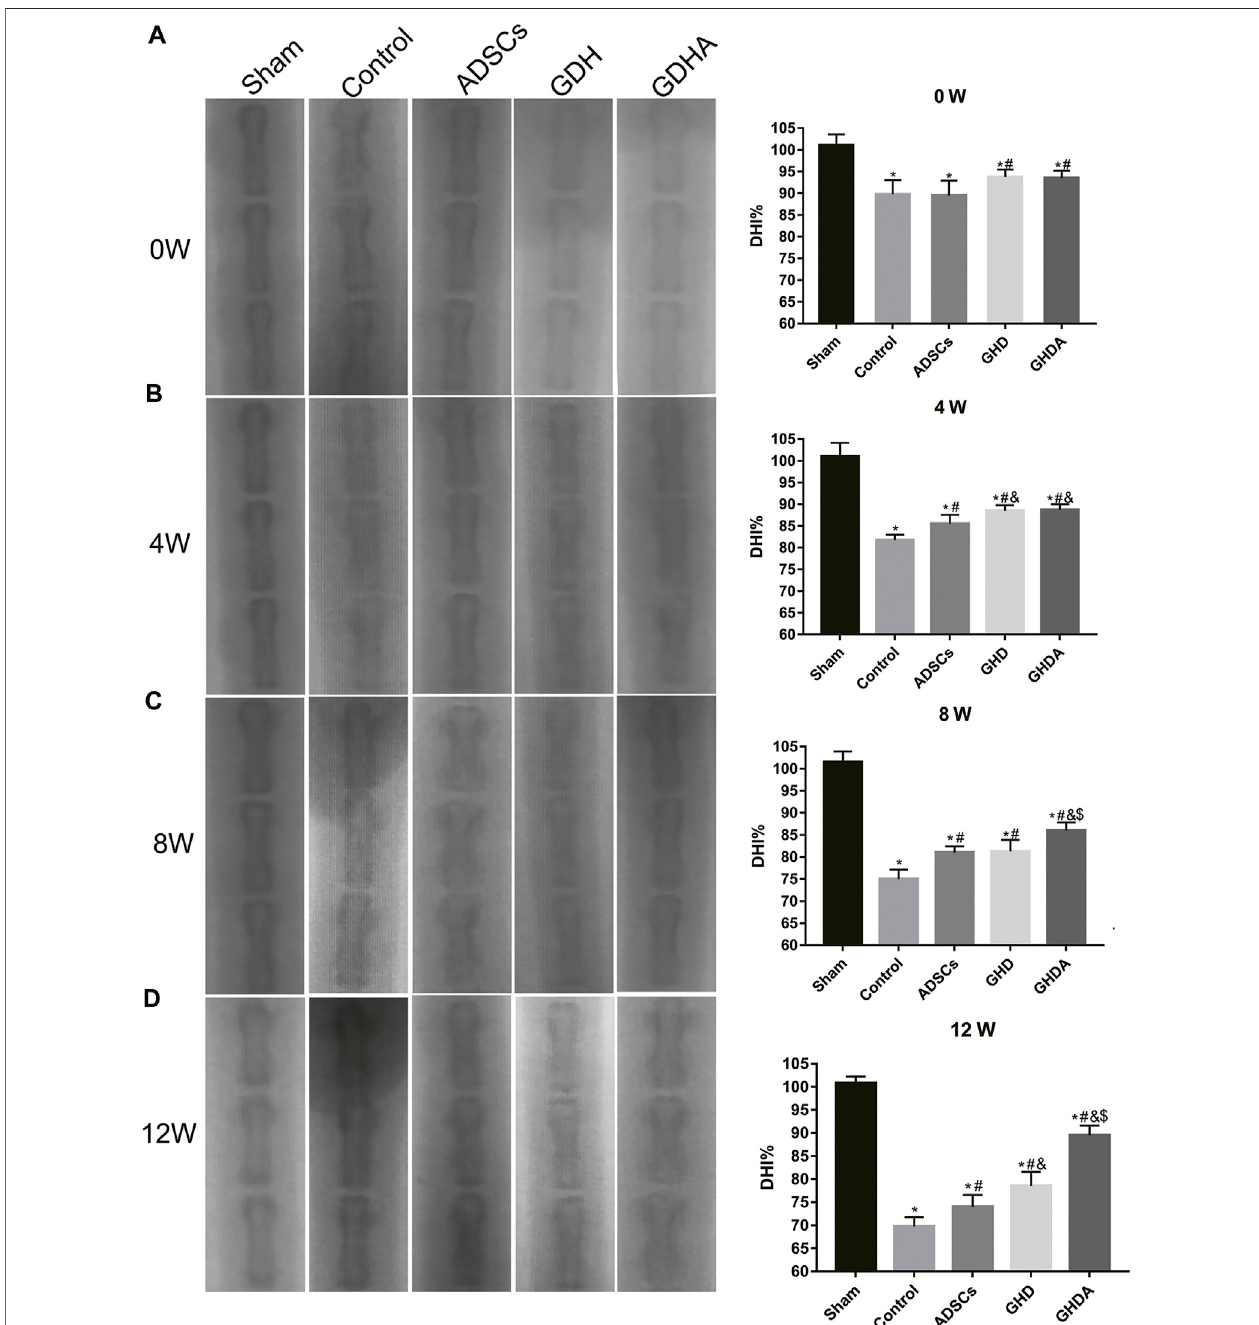
FIGURE 6 | Radiographs of the caudal vertebra and change of the DHI tested by X-ray at 0 (A) , 4 (B) , 8 (C), and 12 (D) weeks after injection. Data represented mean ± SD ( n (cid:2) 5); * p < 0.05, vs. sham group; # p < 0.05, vs. control group; & p < 0.05, vs. ADSCs group; $ p < 0.05, vs. GHD group.